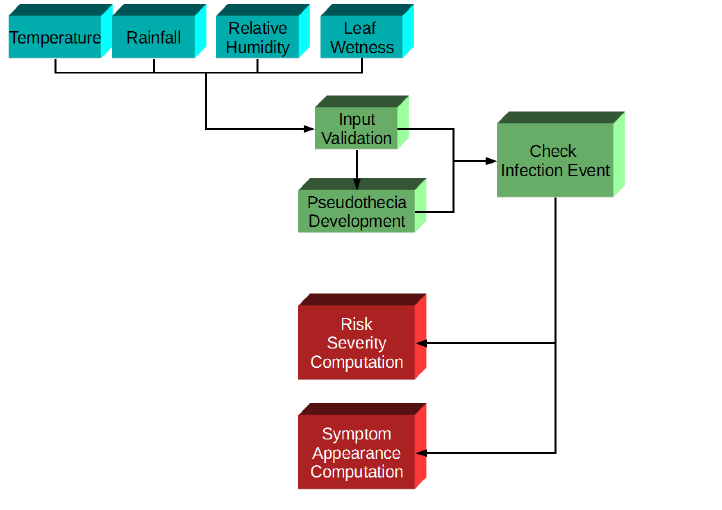
Figure 1. A-Scab main phases